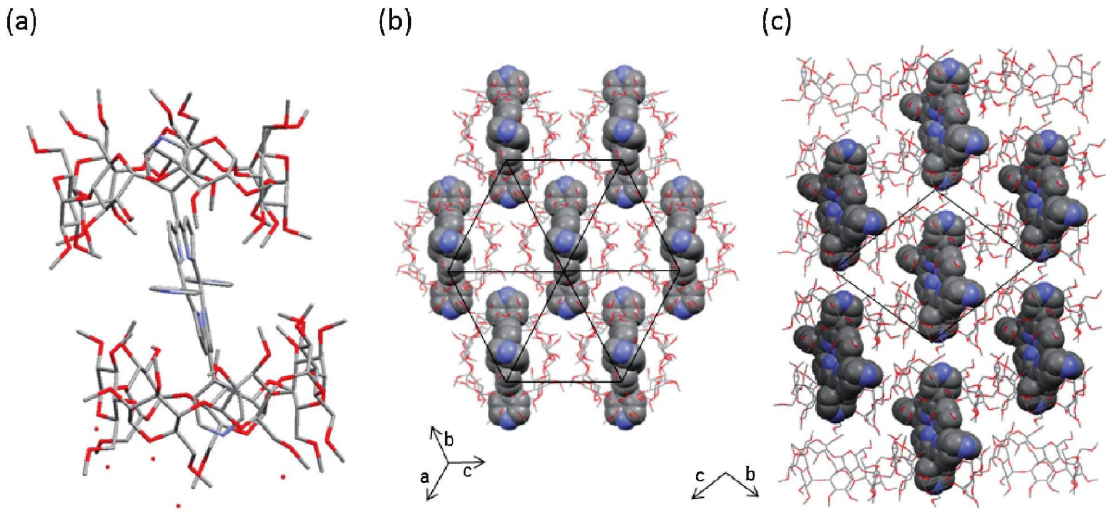
Figure 11. Crystal structure porphyrin-CD complex from ref [58]; ( a ) unit cell, ( b ) (111) plane and ( c ) along the axis. The hydrogen atoms are omitted (reproduced with permission from The Chemical Society of